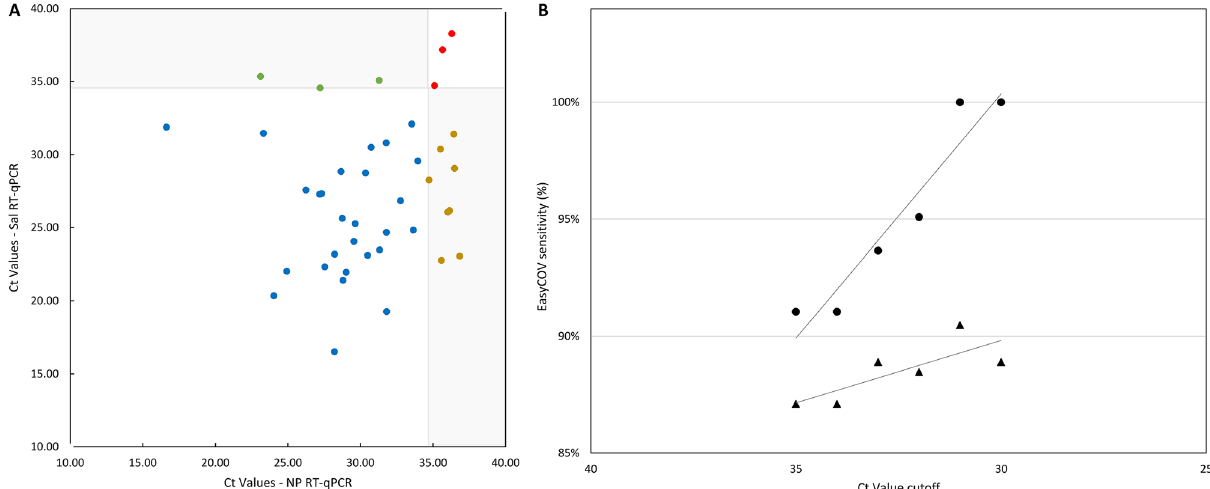
Figure 2. (A) Sensitivity of salivary RT-LAMP evaluated against NP and salivary RT-qPCR Ct values. Ct value cutoffs indicate the infectious status of individuals considered as positive/negative . Dots show sensitivity (%) of RT-LAMP against salivary RT-qPCR (R 2 = 0.92). Triangles show sensitivity (%) of salivary RT-LAMP compared to NP RT-qPCR (R 2 = 0.61). RT-qPCR, reverse transcription quantitative polymerase chain reaction; RT-LAMP, reverse transcription loop-mediated isothermal amplification; NP, nasopharyngeal; Sal, salivary; Ct, cycle threshold. (B) Comparison of Ct Value between NP and salivary RT-qPCR. Dots represent experimentally measured Ct values of nasopharyngeal (X) and salivary (Y) RT-qPCR. Positive concordant individuals (positive for both NP and salivary RT-qPCR) are in down left white corner . Negative concordant individuals (Ct value ≥ 35 for both NP and salivary RT-qPCR) are in upper right white corner . Discordant results (negative for one specimen and positive for the other in RT-qPCR) are on the grey zones of the graphic (NP+/Sal- ; NP-/Sal+ ).